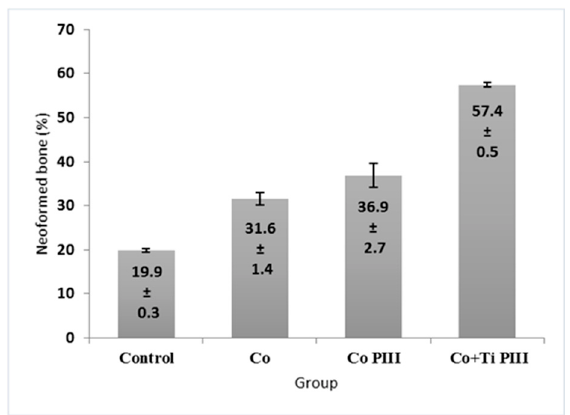
Figure 7. Percentage (%) of newly formed bone in the studied groups. G1 (Control), G2 (Co), G3 (Co PIII), G4 (Co+Ti PIII).